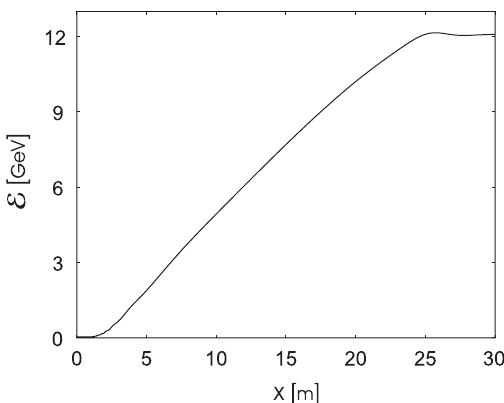
FIG. 6. Particle continuous reflection and acceleration at the variable undulator step along the axis is illustrated at (cid:2) 0 ¼ 0 : 2 , (cid:5) 0 ¼ 150 T , w 0 ¼ 6000 (cid:4) , and (cid:2) 10 cm